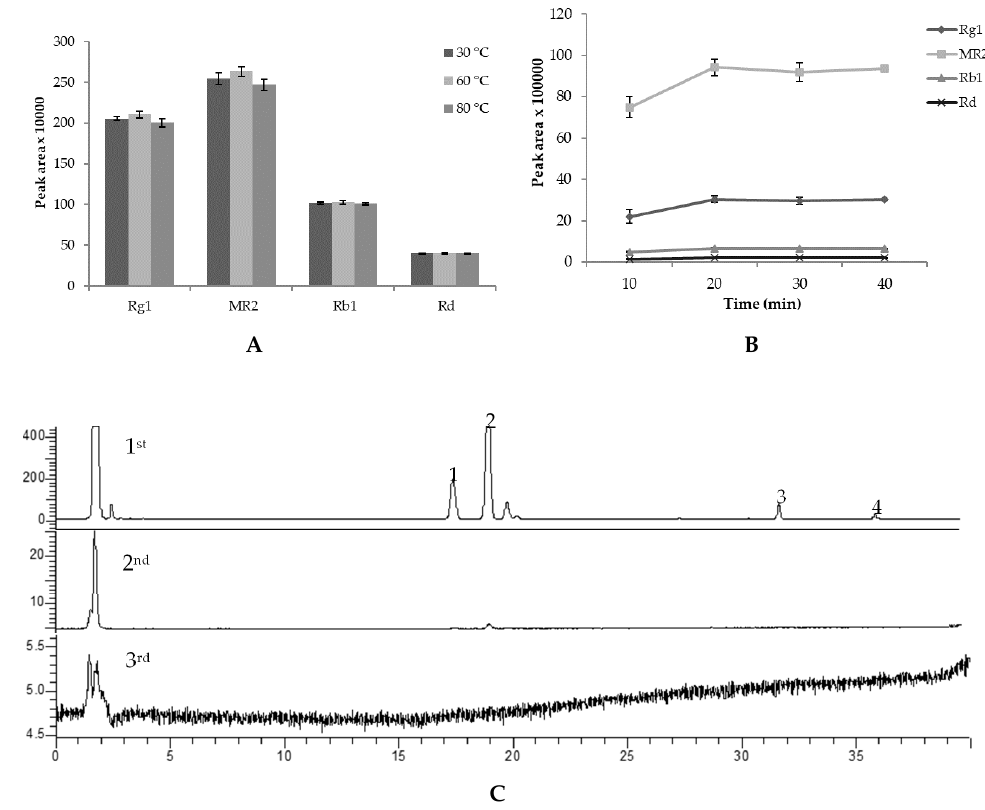
Figure 3. Peak area of main saponins of PV extracted at different extraction temperatures ( A ), duration ( B ), and extraction at 1st, 2nd, and 3rd times ( C ). The results of A and B expressed at the mean and standard deviation of a triplicated experiment.